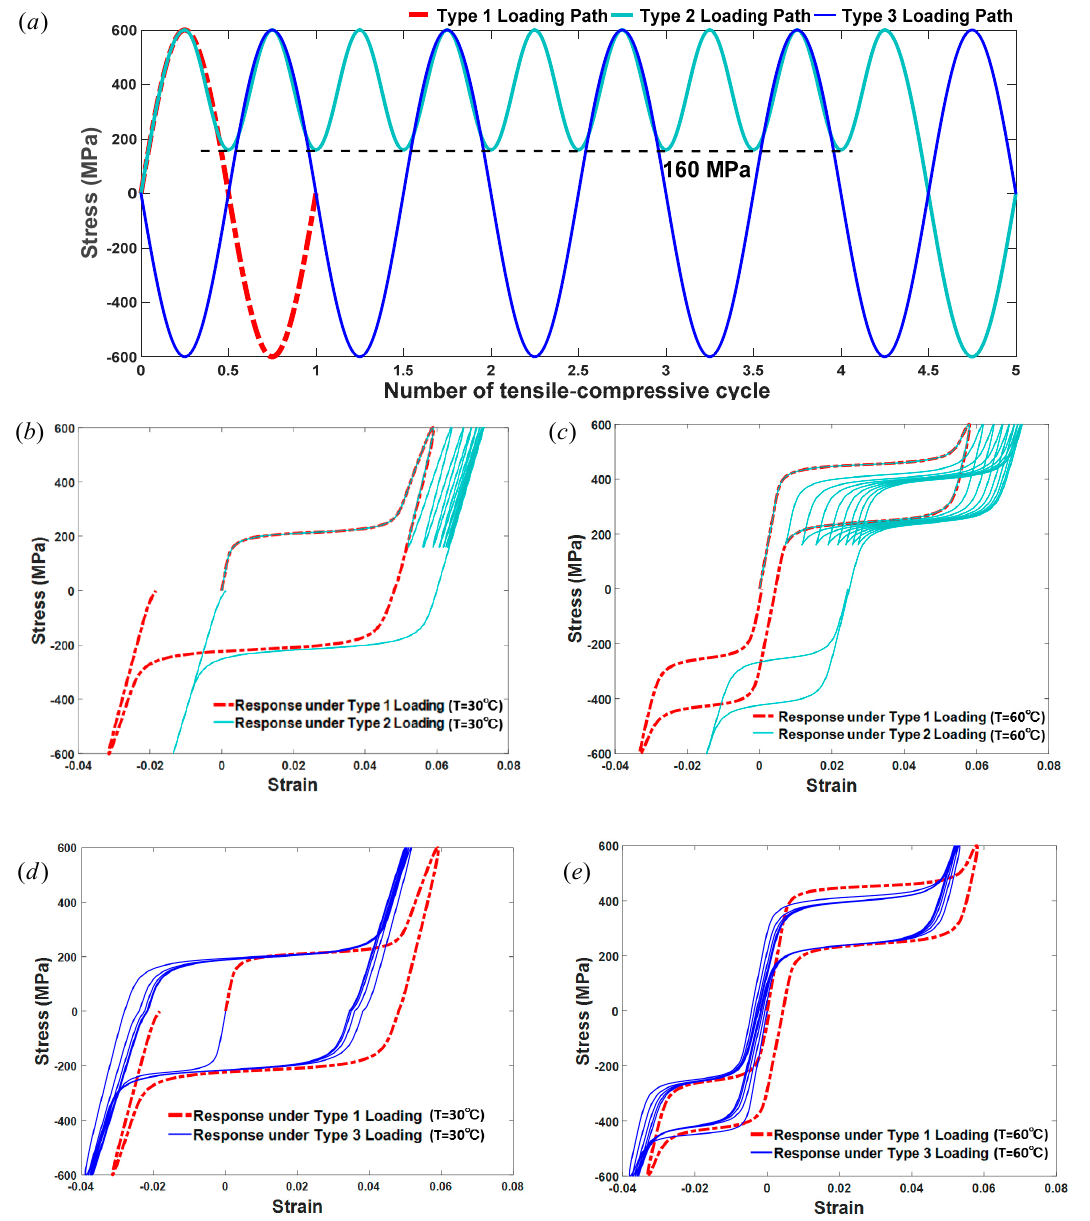
Figure 9. The temperature-dependent constitutive behavior of SMAs under three different types of loading path. ( a ) The loading paths along with the increase in the tensile-compressive cycle; ( b ) The strain–stress relationship of SMAs under Type 2 loading at T = 30 ° C; ( c ) The strain–stress relationship of SMAs under Type 2 loading at T = 60 ° C; ( d ) The strain–stress relationship of SMAs under Type 3 loading at T = 30 ° C; ( e ) The strain–stress relationship of SMAs under Type 3 loading at T = 60 ° C.